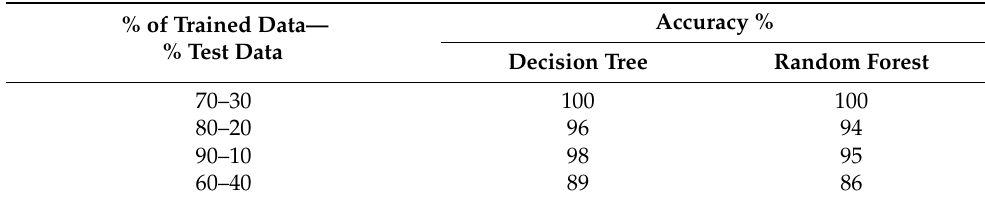
Table 11. Iteration on independent